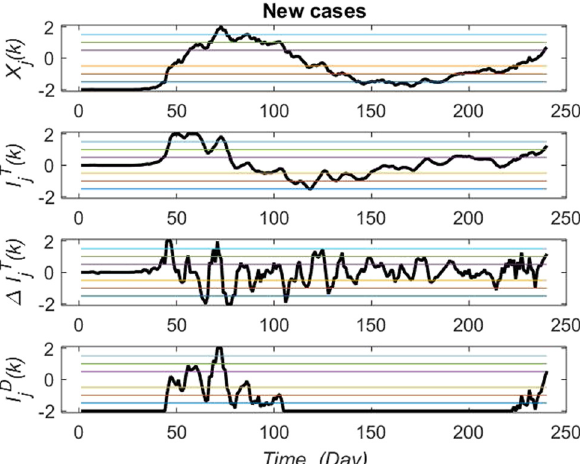
Figure 9: Temporal analysis for the new con fi rmed cases during the starting part until Day 240 in Finland.